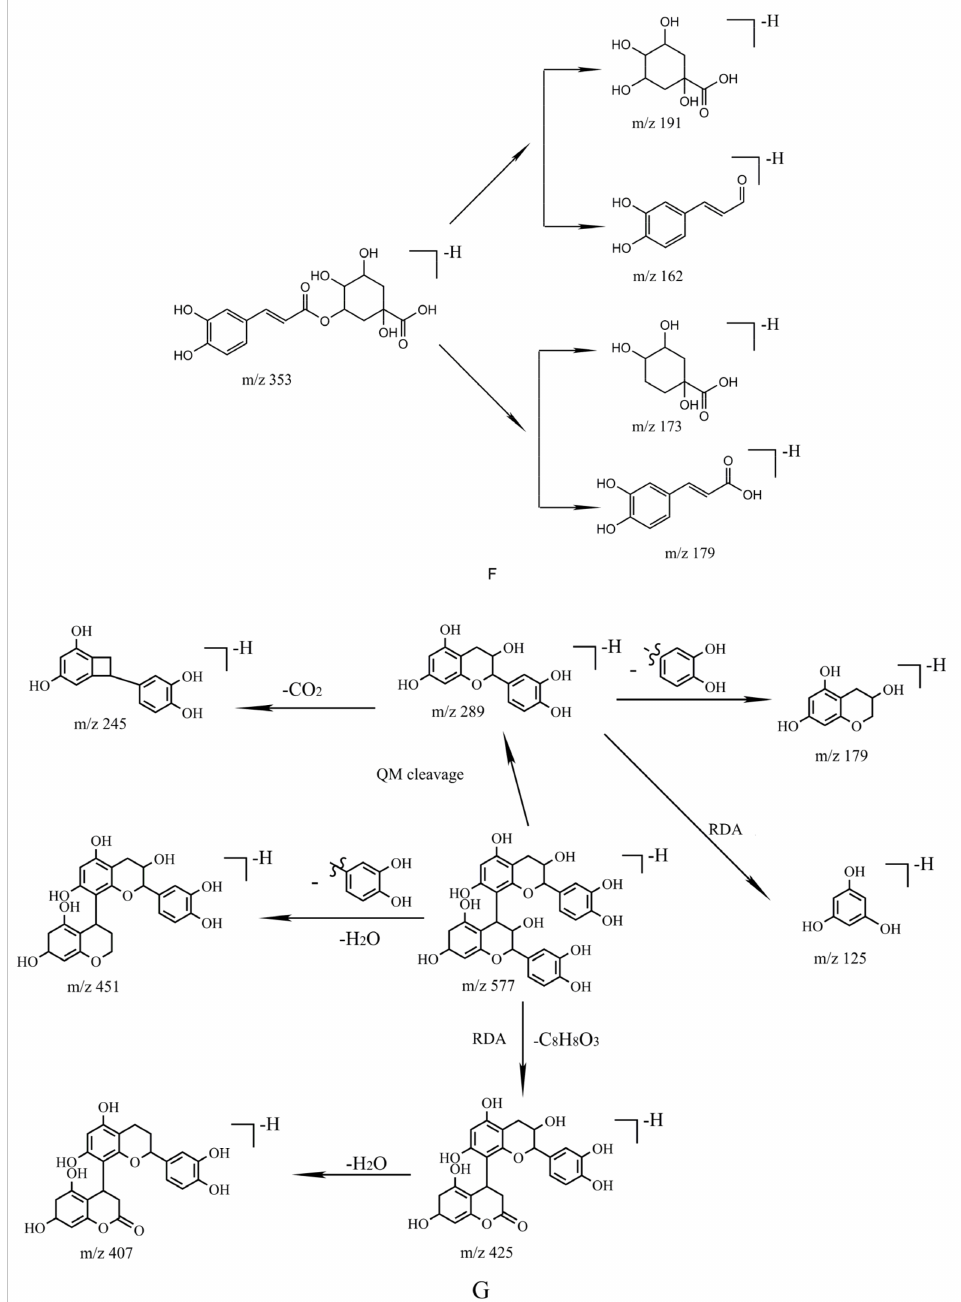
Figure 4. The possible fragmentation pathways of Prunin ( A ), (+)-catechin ( B ), Luteolin-7-O-glucoside ( C ), Quercetin ( D ), Gallic acid ( E ), Chlorogenic acid ( F ), and Procyanidin B2 ( G ) in Taxilli